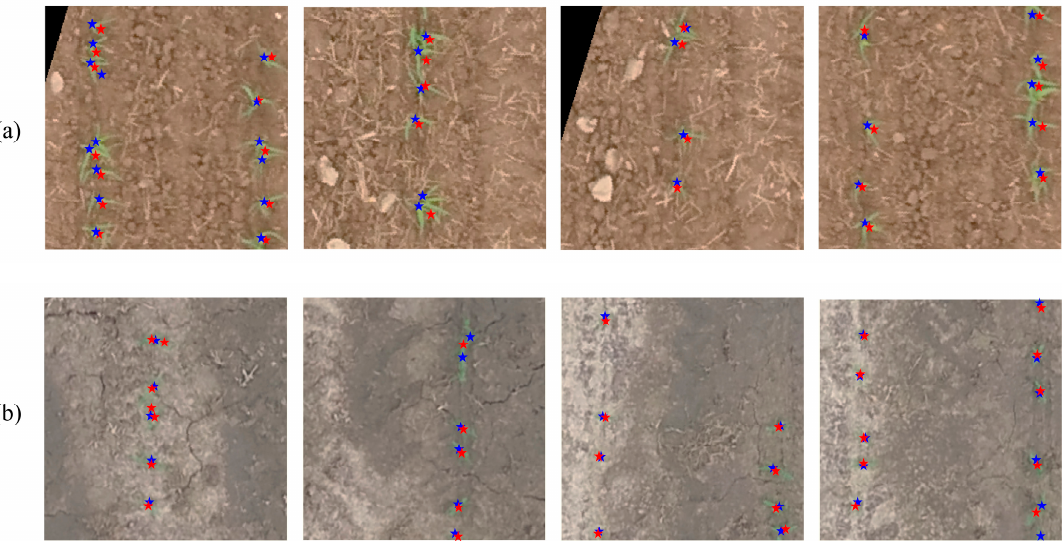
Figure 12. Visual comparison of detected plants with their ground truth locations for the extracted patches from ( a ) first image ( b ) second image. Blue stars are ground truth points, and the red ones are predicted based on the model.